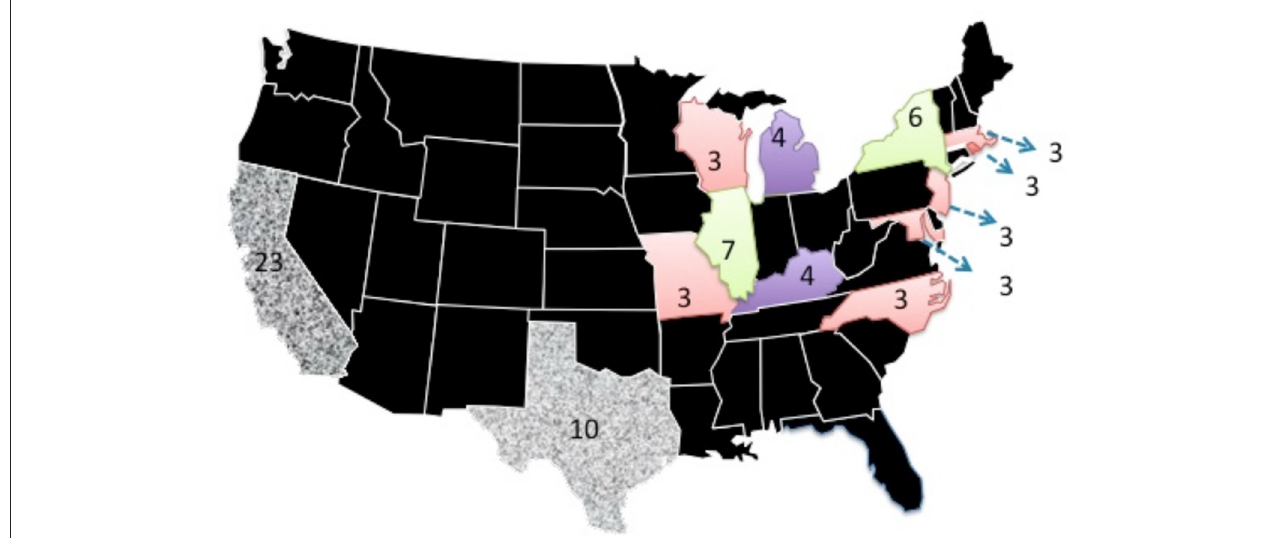
FIGURE 1 | A map of the states included in three or more